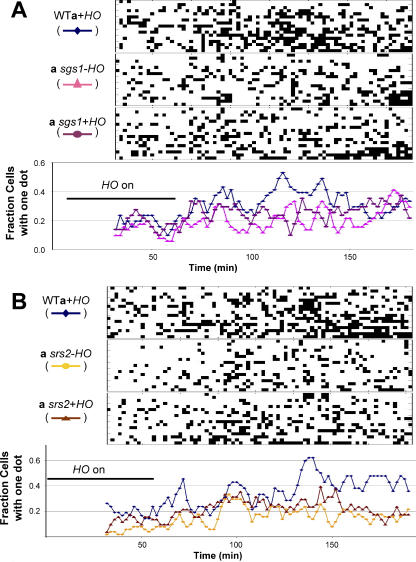

HML and MAT Fail to Pair in sgs1 or srs2 MutantsData were obtained for 17 cells under each condition and presented as described in Figure 2 for sgs1 (A) and srs2 (B) mutant strains, with the difference that cells were interrogated every 2 min starting 30 min after addition of galactose.